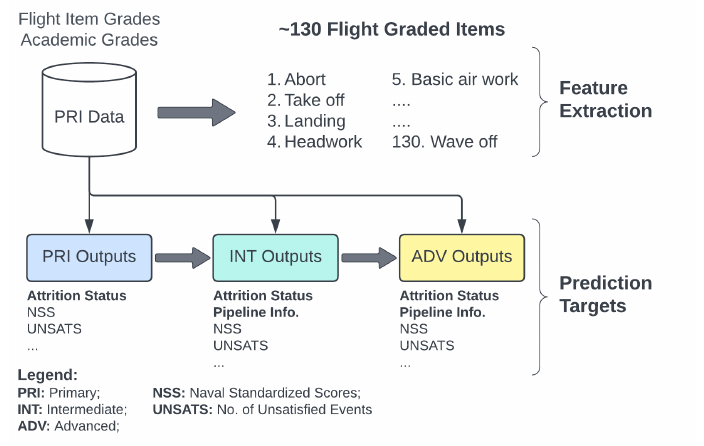
Figure 5. Overview of datasets used in this